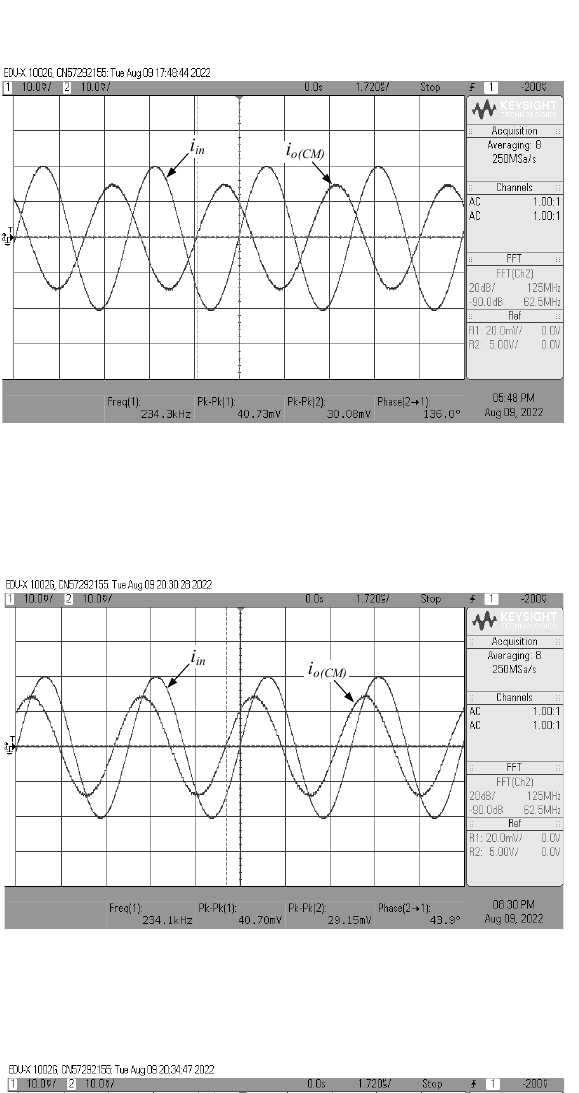
Figure 14. Measured time and frequency responses of the proposed TAM filter: ( a ) LP; ( b ) HP; and ( c ) AP.